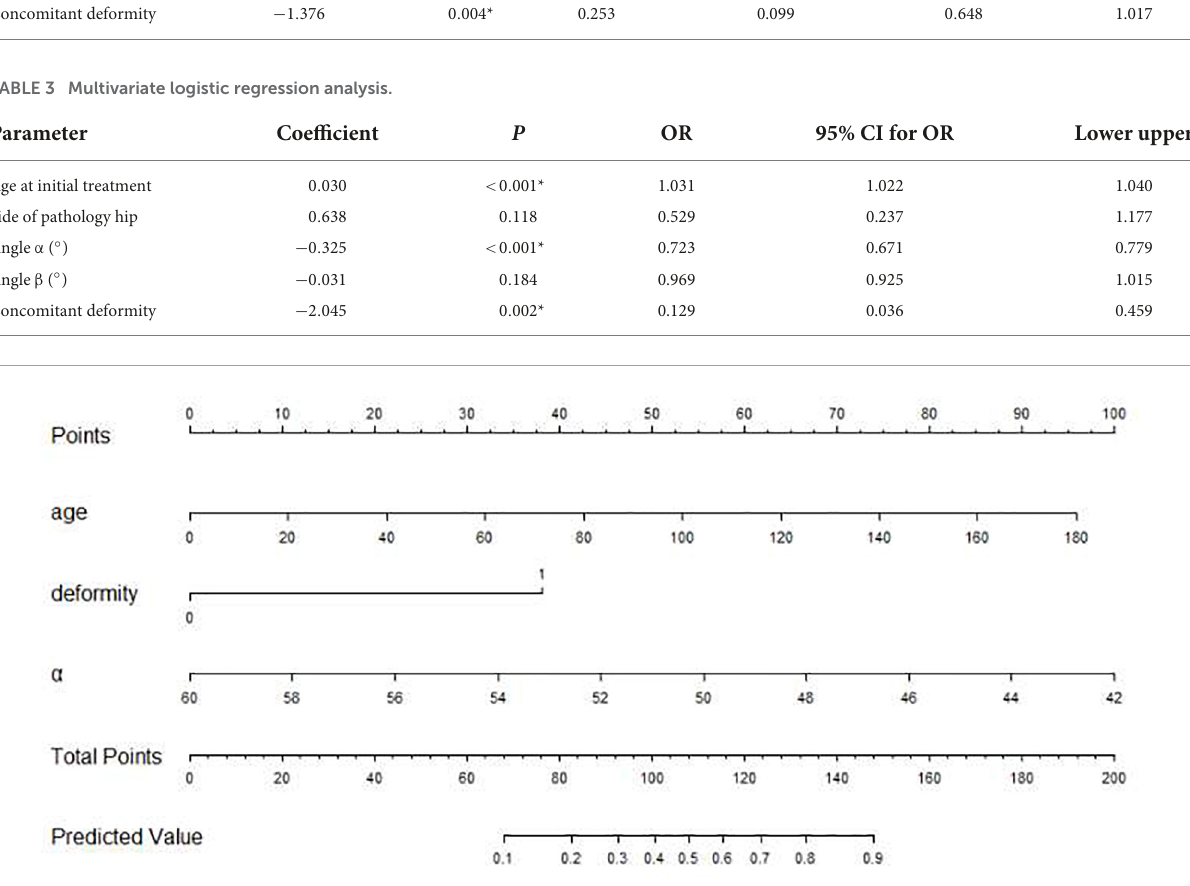
FIGURE1 The nomogram for predicting the failure rate of Pavlik harness. Based on age, deformity, and angle α (age: days; deformity: 0: without concomitant deformity, 1: with concomitant deformity; angle α : degrees), we can get a total point, corresponding to the predicted value.